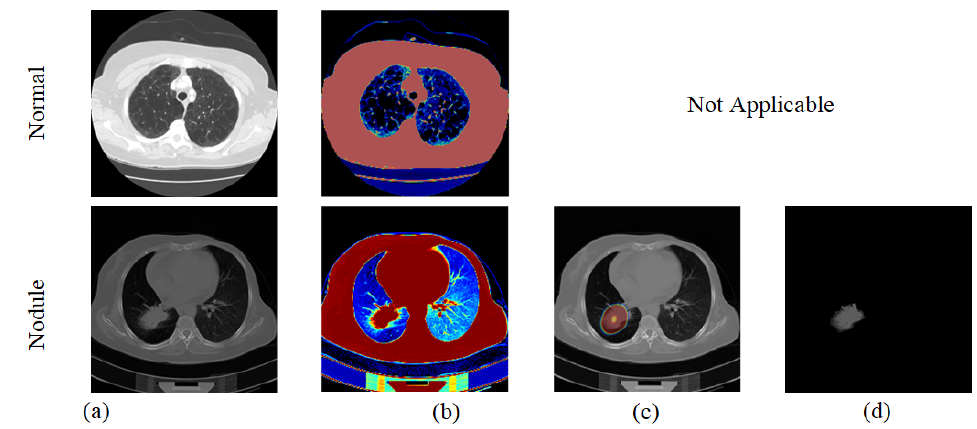
Figure 4. Results obtained with proposed VGG-SegNet scheme: ( a ) text image, ( b ) lung section enhanced by encoder, ( c ) localization of nodule by decoder and ( d ) extracted nodule by SoftMax unit.